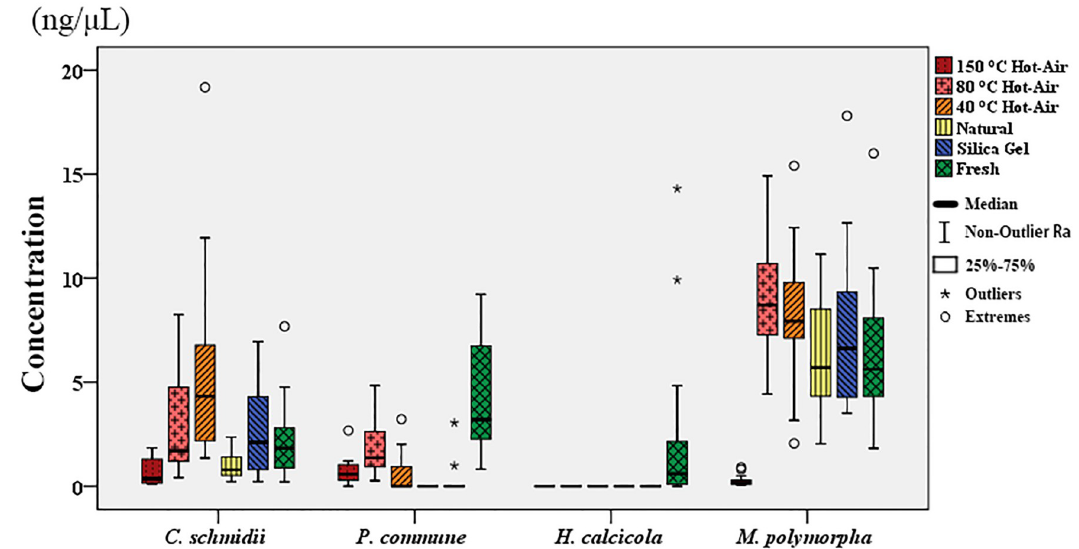
Fig 3. The concentration of extracted high-molecular weight genomic DNA by agarose gel electrophoretogram after different drying methods.